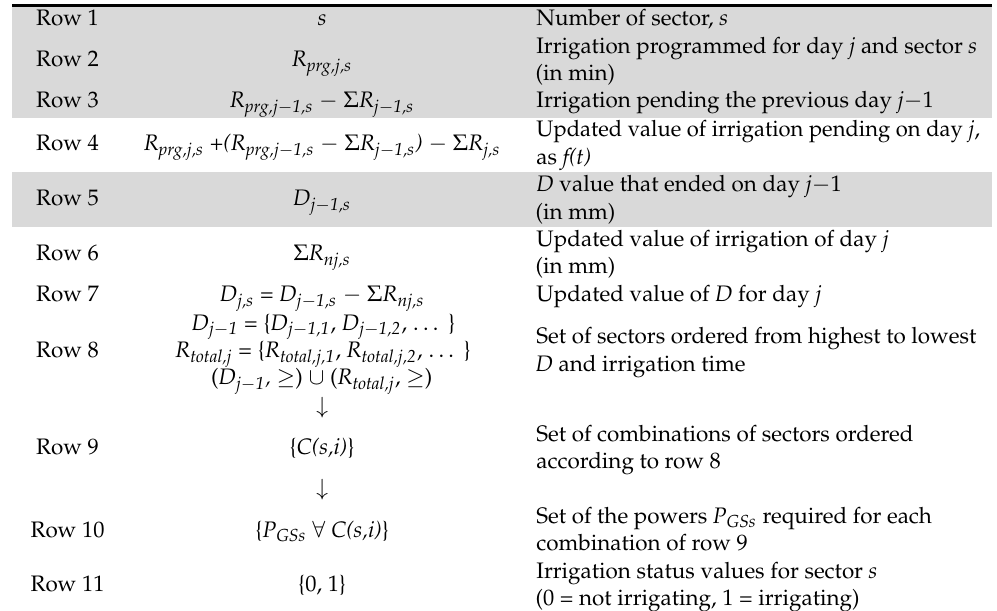
Table 3. Data from the daily work matrix for power management. R prg,j,s = Irrigation scheduled for day j and sector s , in minutes. Σ R j,s = Sum of irrigation carried out on day j and sector s , in minutes. Σ R nj,s = Sum of the net irrigation carried out on day j in sector s , in mm. R total,j,s = R prg,j,s + R prg,j − 1,s − Σ R j − 1,s. C(s,i) = Combination of the s sectors taken in groups of i sectors according to the order of row 8. P GSs = Minimum demand power for the combination C(s,i) , in W. The shaded rows have fixed values for the entire